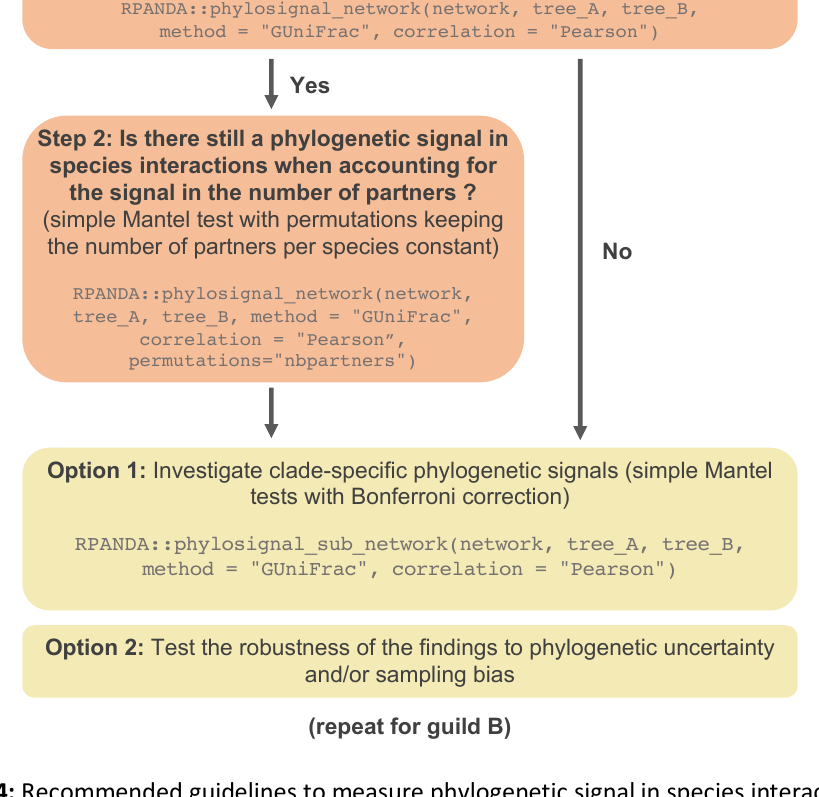
Figure 4: Recommended guidelines to measure phylogenetic signal in species interactions within bipartite ecological networks. This guideline is composed of two fixed steps followed by two optional ones and can be applied as soon as a bipartite interaction network (with or without abundances) and at least the phylogenetic tree of guild A are available. The phylogenetic tree does not need to be binary, rooted, or ultrametric. For each step, an example of the corresponding function available in the R-package RPANDA is indicated in grey. Step 1: The first step consists of testing for a phylogenetic signal in species interactions for guild A ( i.e. whether closely related species from guild A tend to interact with similar partners from guild B) using a one-tailed simple Mantel test. This step requires picking an ecological distance ( e.g. UniFrac or Jaccard distances) and a type of correlation (Pearson correlation by default). Step 2: Next, to assess whether a phylogenetic signal in species interactions really comes from the identity of species interactions (and not from a phylogenetic signal in the number of partners), the second step consists of testing whether the phylogenetic signal in guild A remains significant when the significance of the Mantel correlation is evaluated using network permutations keeping the number of partners constant. Option 1: Clade-specific phylogenetic signals in guild A can be tested using simple Mantel tests while correcting for multiple testing ( e.g. Bonferroni correction). It can be used to test whether some clades present different intensities of phylogenetic signals ( e.g. because of higher specificity). Option 2: The robustness of the findings can be tested by looking at how the conclusions might be affected by phylogenetic uncertainty ( e.g. using a Bayesian posterior of tree) or sampling bias. The potential effect of sampling bias can be investigated by subsampling all clades to the same number of species. If a phylogenetic tree for guild B is available, all these steps can be replicated to test for the phylogenetic signal in species interaction in guild